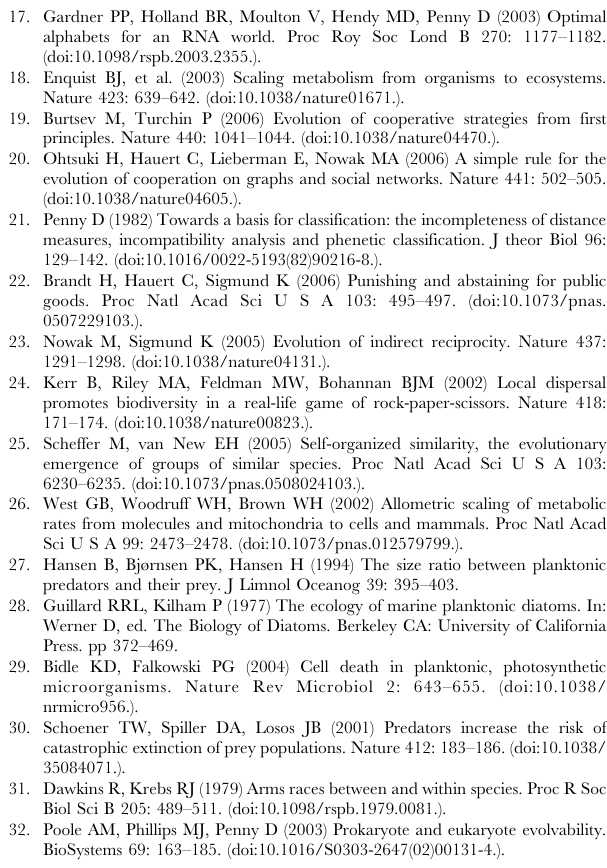
Figure S2 Development of total number of unicells without predatory carnivory. There is an exponential growth curve after an initial lag phase during which the initial unicell population evolves to smaller size (at which replication is much faster).